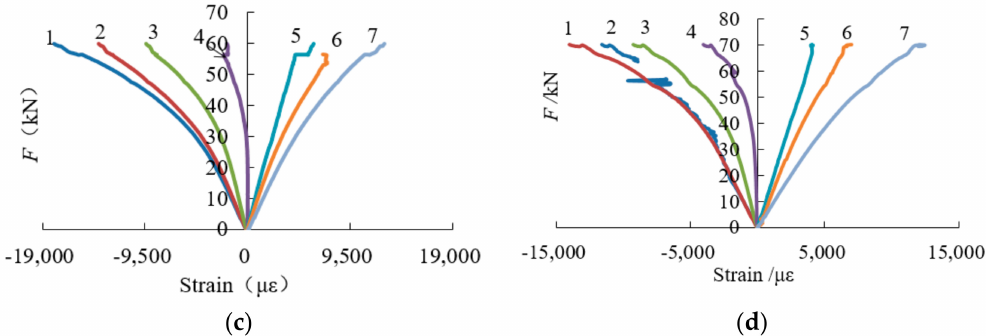
Figure 13. Typical load–strain curves for four groups: ( a ) load–strain curves for specimen NAP-2; ( b ) load–strain curves for specimen LAP1-3; ( c ) load–strain curves for specimen LAP2-2; ( d ) load–strain curves for specimen LAP3-2.